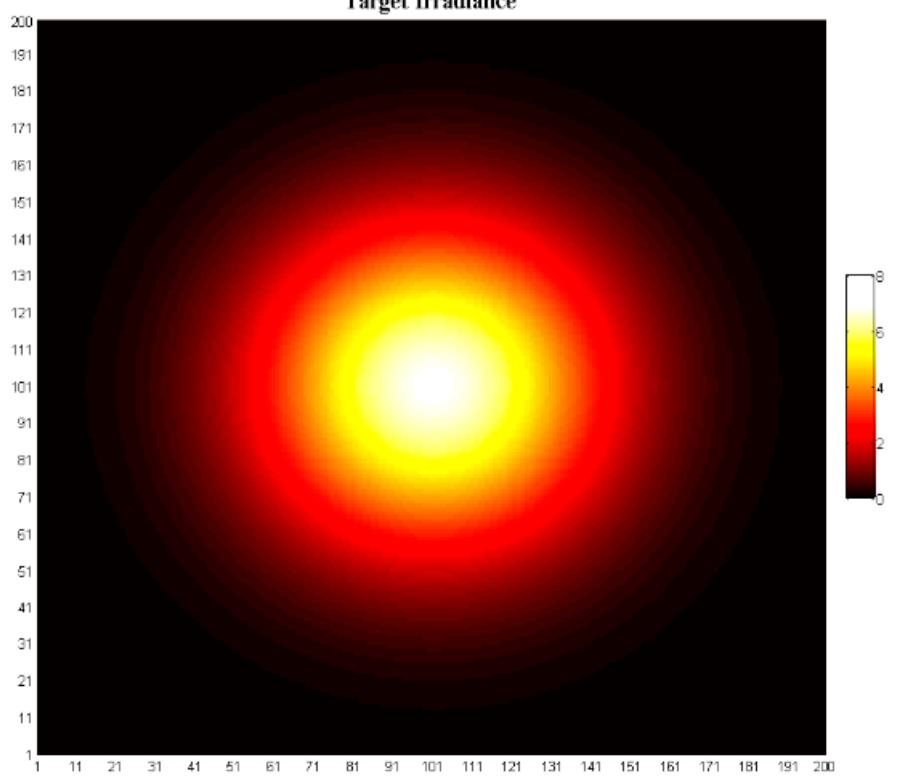
Figure 9. The map of the target, expressed as calculated concentration, for 2 L F = 2 m with 8 × 8 facets.